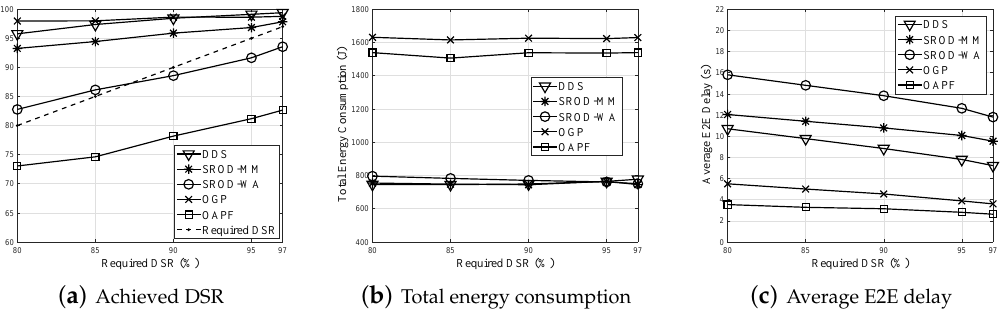
Figure 5. Effects of the DSR on the achieved DSR, total energy consumption in the network, and average E2E delay with delay bound θ = 30 s and an event rate of 0.5